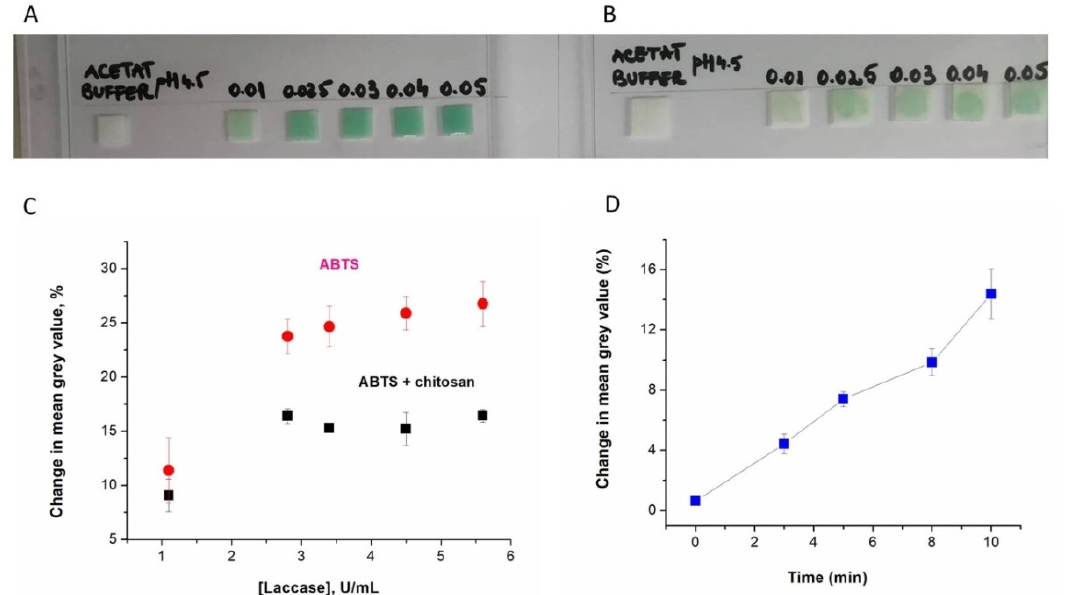
Figure 2. ( A , B ) Color changes of the paper sensors impregnated with either 0.4 mg/mL ABTS ( A ) or 0.4 mg/mL ABTS and 0.5 mg/mL chitosan in a 0.1 M acetate buffer of pH 4.5 ( B ) after 10 min of reaction with acetate buffer and solutions of laccase of 0.01 mg/mL, 0.025 mg/mL, 0.03 mg/mL, 0.04 mg/mL, and 0.05 mg/mL, having activities of 1.1 U/mL, 2.9 U/mL, 3.5 U/mL, 4.7 U/mL, and 5.9 U/mL, respectively (from left to right). ( C ) The corresponding change in color intensity (estimated through the mean grey value using ImageJ) for ABTS and ABTS–chitosan paper sensors. ( D ) Evolution in time of the color intensity of an ABTS paper tested with 1.1 U/mL laccase in a 0.1 M acetate buffer of pH 4.5.